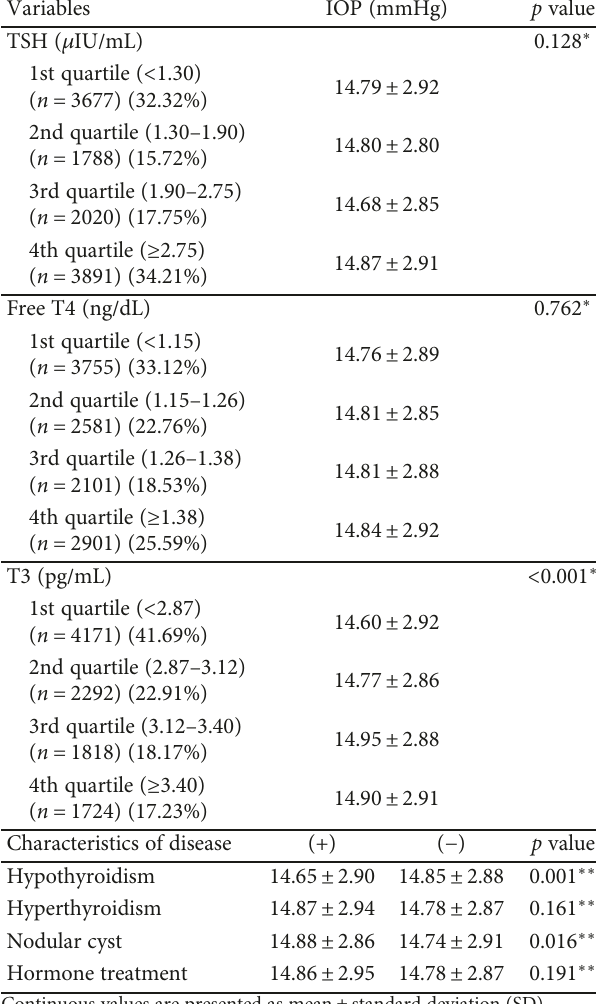
Table 4: Univariate analysis of thyroid function and IOP in thyroid disease patients without